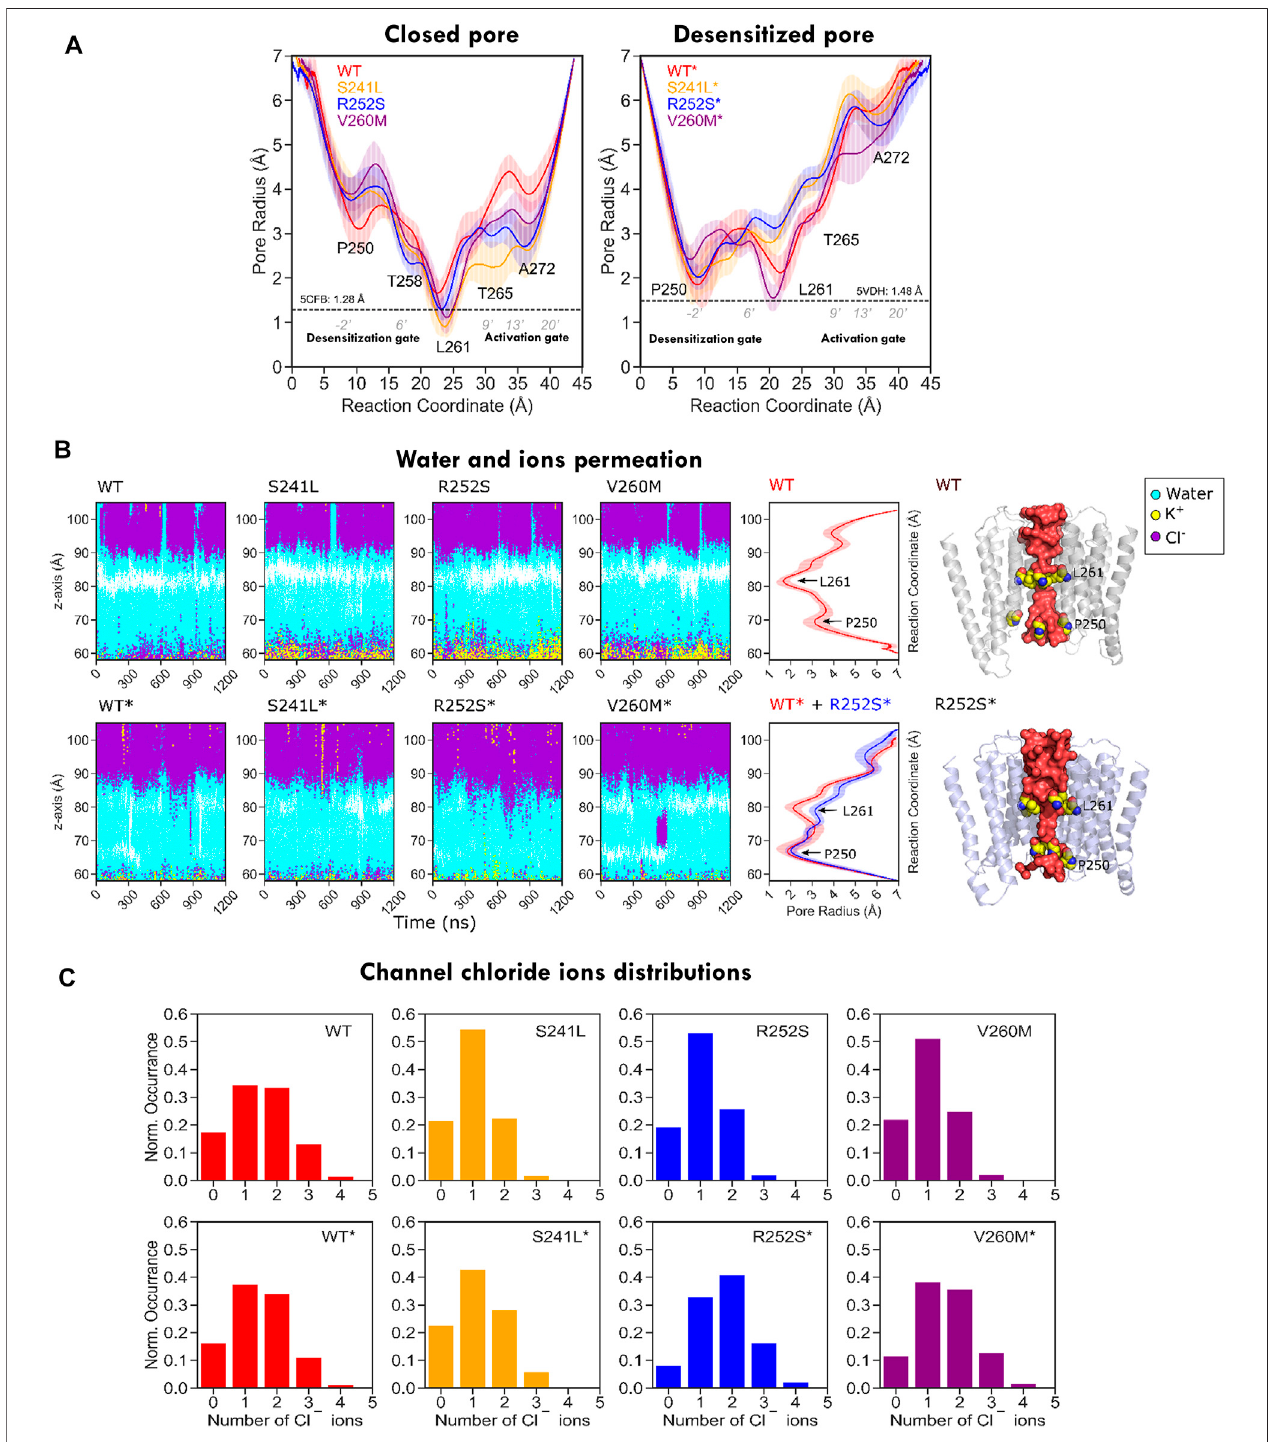
FIGURE 9 | Pore radius pro fi le for WT and mutant GlyR from MD simulations. (A) Pore pro fi les for closed/resting state WT (5CFB) and mutantsconstructed from it are shown to the left; WT* (5VDH) and mutants constructed from it are shown to the right side. Note how in both closed and desensitized/open state simulations all mutants tend to widen the P250 gate. (B) Water and ion permeation across the channel. The closed activation gate in 5CFB simulations (top) appears as a white area around Leu261, missing in desensitized state simulations (bottom). Chloride ions cross the area in WT* and V260M* in relation with permeation events (see Supplementary Movies S1, S2 ); there is also an entry of potassium ions through the selectivity fi lter (P250) in closed state simulations (yellow), but they stay in the vestibule. (C) Chloride ion distribution inside the channels; note the shift to the right for mutants due to the wider channels accommodating a larger number of ions.